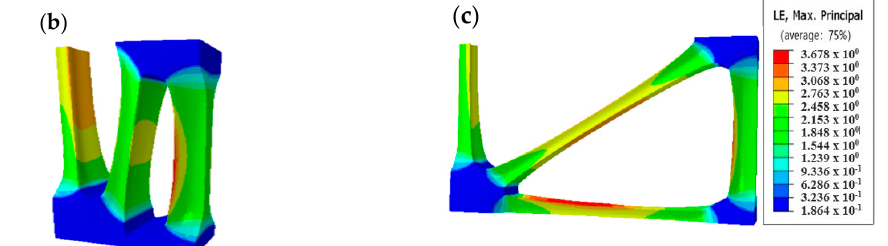
Figure 17. Strain contours of the stretching simulation of performance optimization multi-axial geogrid. ( a ) Initial shape, ( b ) Longitudinal stretch, ( c ) Transverse stretch.